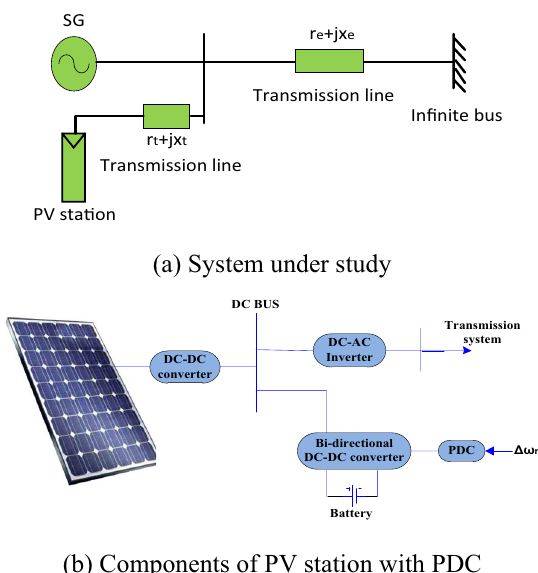
Fig. 1 Bulk PV station with SG connected to infinite